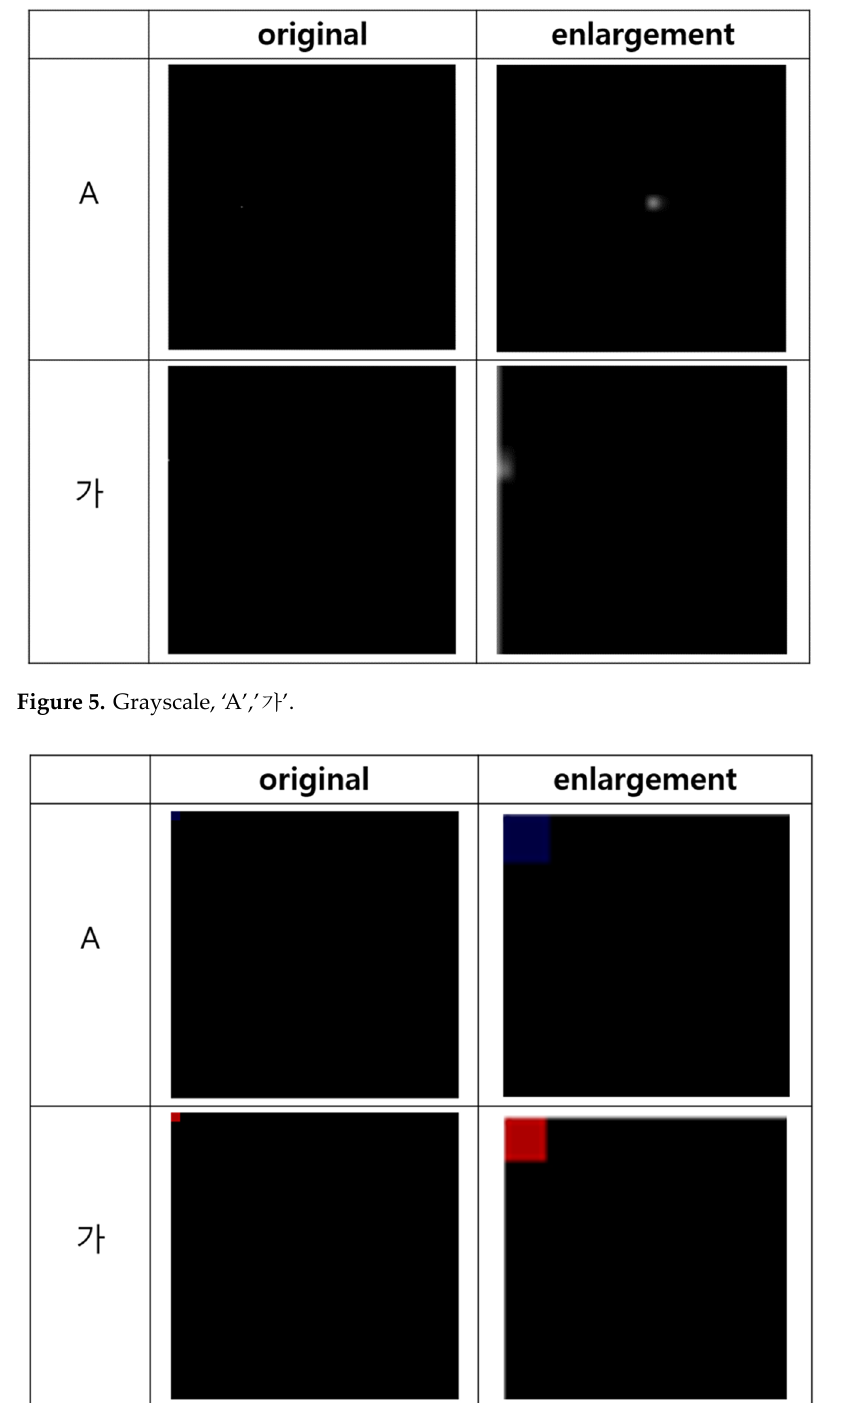
Table 7. Unicode and coordinate values of characters.